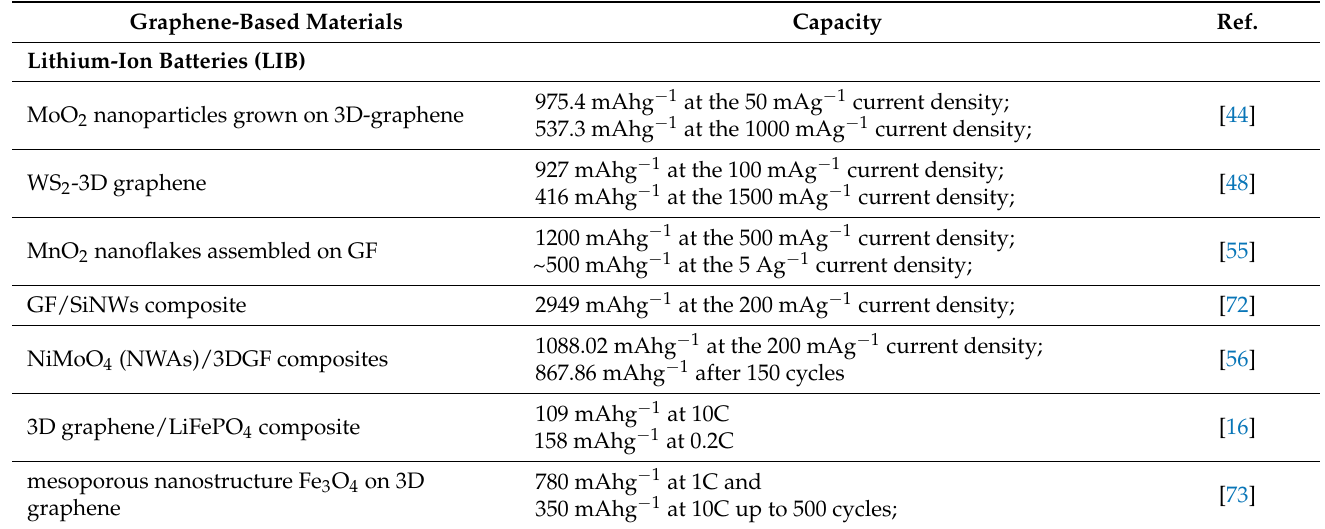
Table 4. The performance of several battery configurations where 3D graphene was